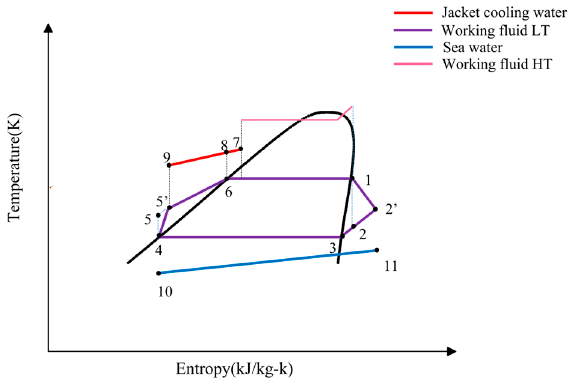
Figure 6. T-s diagram of the LT loop.